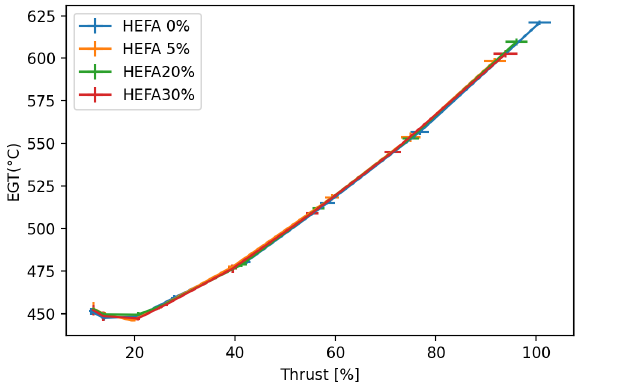
Figure 28. DGEN 380/HEFA: